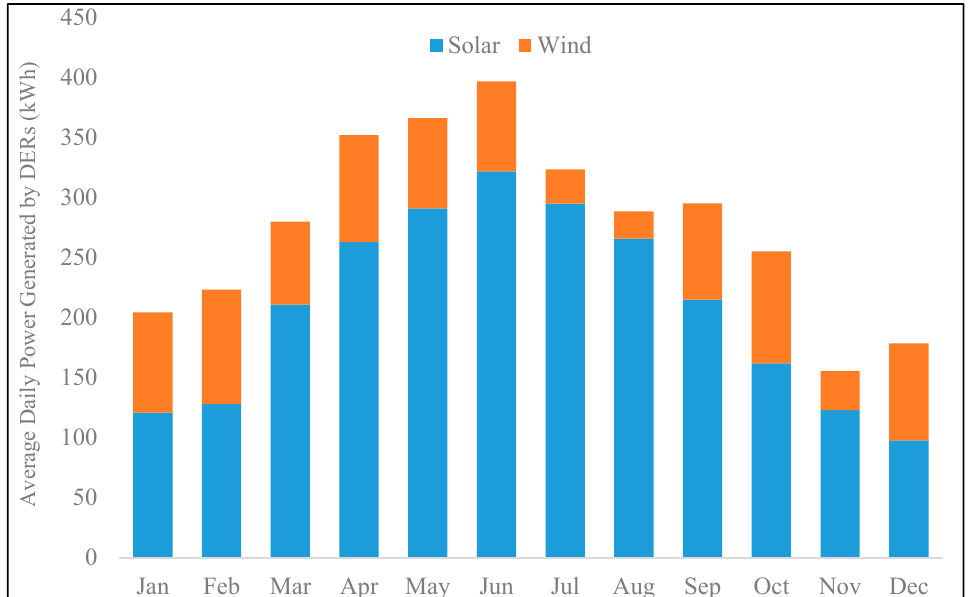
Figure 19. Average daily power generated by solar and wind methods.